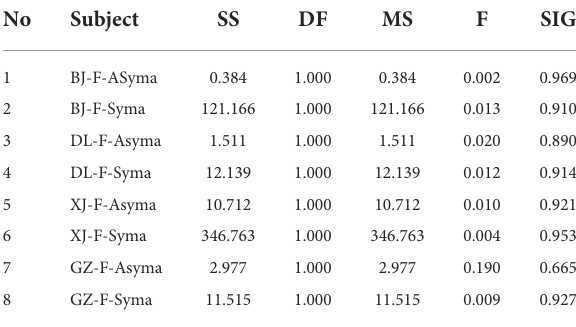
TABLE 3 Analysis of the “F-test” in symptomatic and asymptomatic